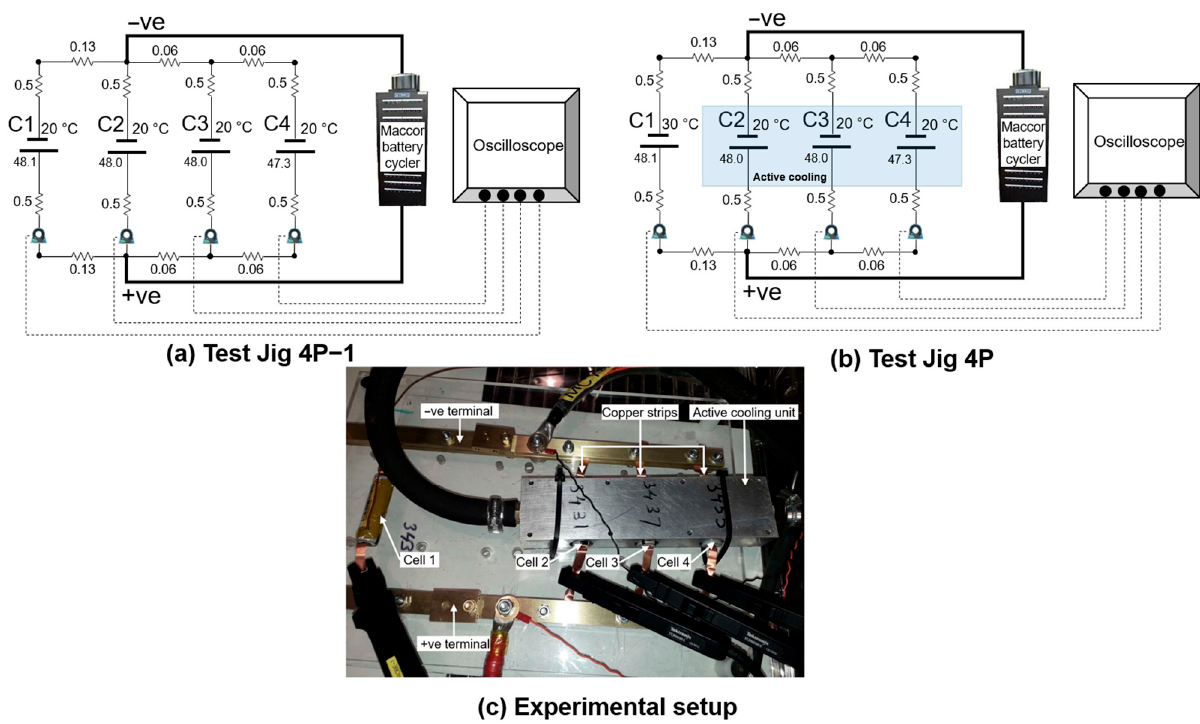
Figure 1. ( a ) Schematic of four cells in parallel with an air cooling at 20 °C ( b ) a parallel configuration with a temperature gradient, C1 at 30 °C room temperature and C2, C3 and C4 at 20 °C active cooling ( c ) real experimental setup of the configuration in ( b ).